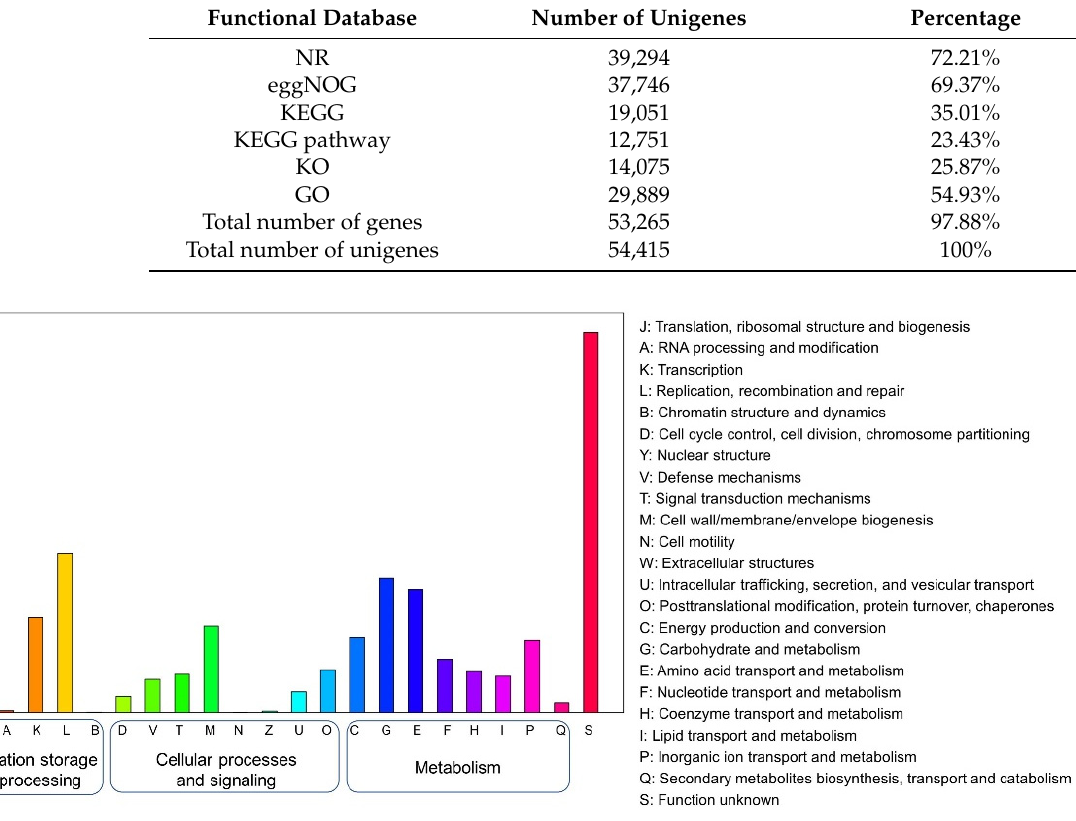
Figure 3. Functional classification of the microbial functional gene eggNOG in suansun .